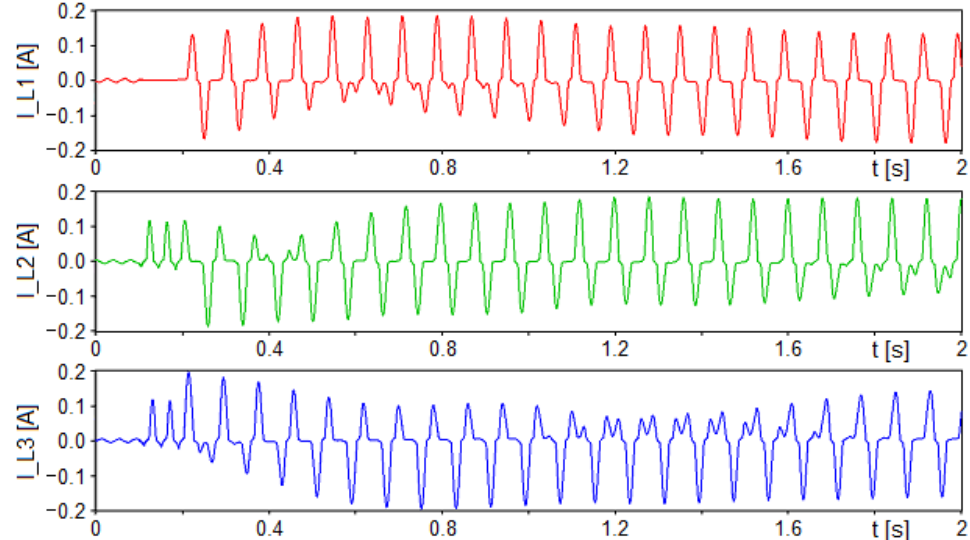
Figure 6. Current waveforms on the primary side of voltage transformers under ferroresonant oscillation conditions.